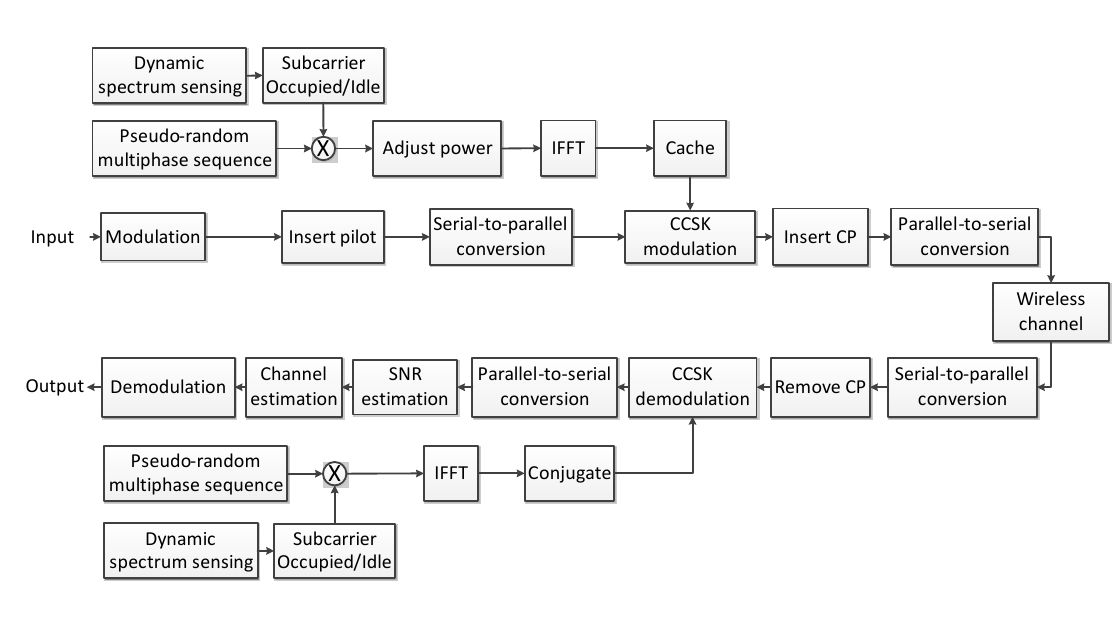
Figure 3. The basic principle of TDCS